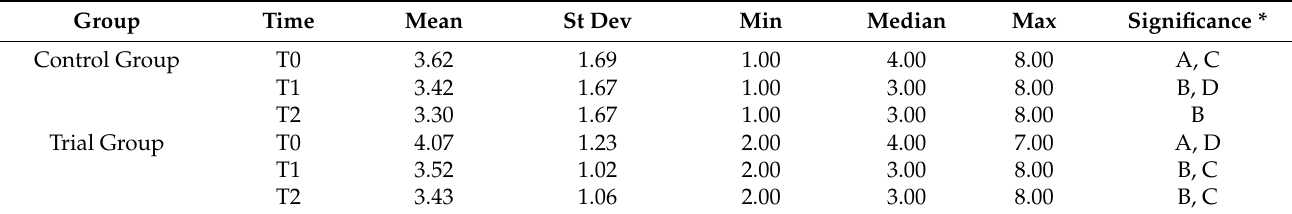
Table 7. Descriptive statistics of PPD measurements.